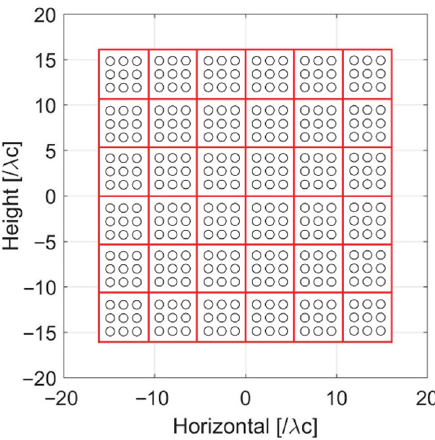
Figure 3. There are 324 optional positions to place effective virtual elements.